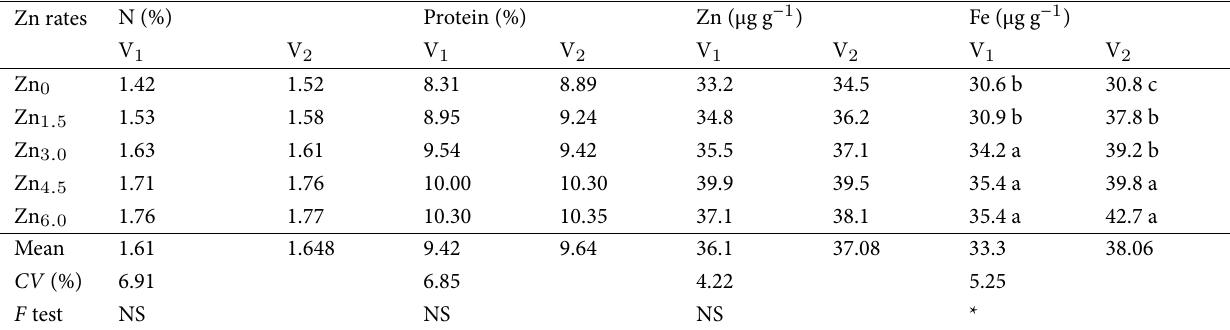
Table 9 Nitrogen, protein, Zn, and Fe concentrations of wheat grains influenced by Variety × Zn Rate interaction. Zn